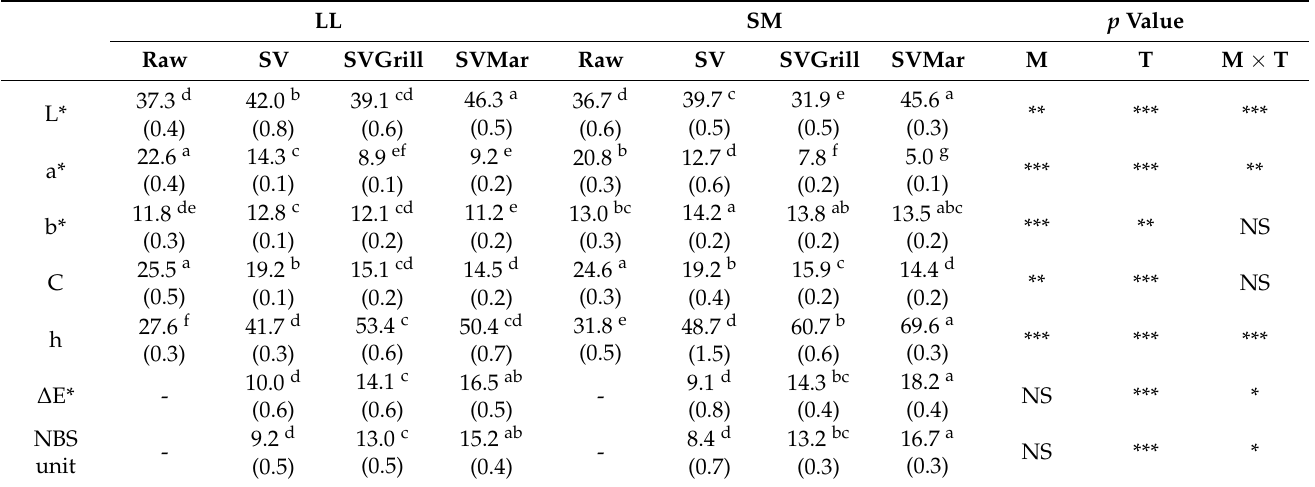
Table 2. Effects of muscle (LL: longissimus lumborum ; SM: semimembranosus ) and treatment (SV =sous vide, SVGrill = sous vide and subsequent grilling, and SVMar = marinating and sous vide) on colour attributes (mean values and standard error of the mean in brackets).